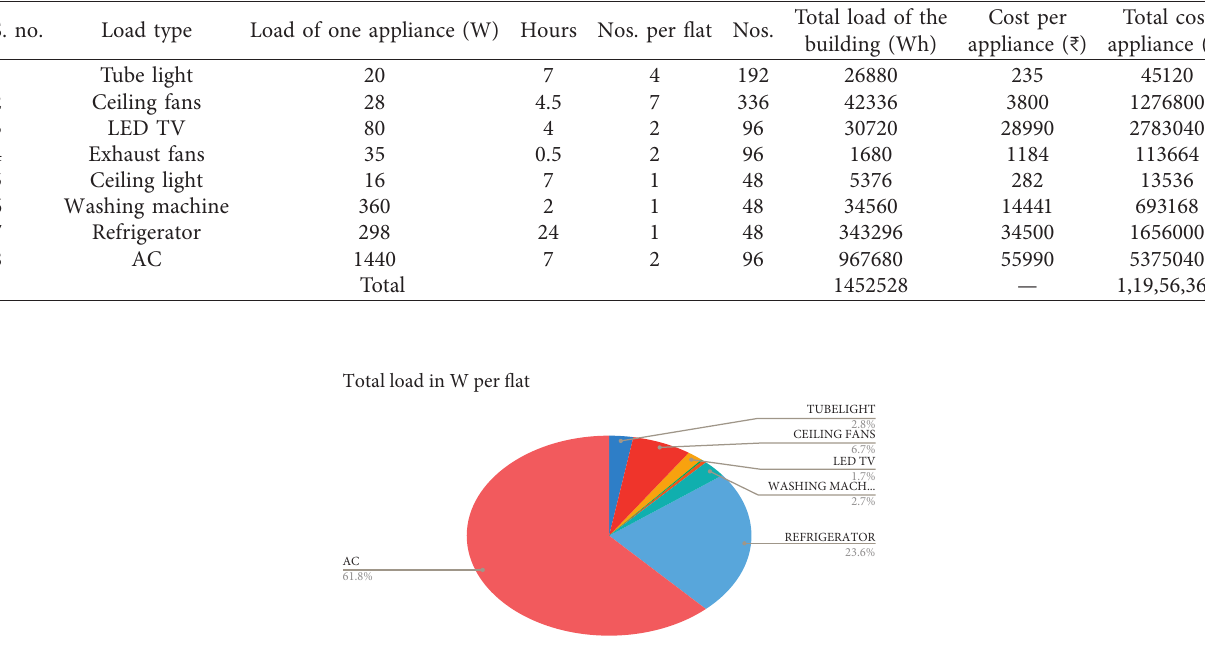
Figure 8: Load distribution—conventional loads—3BHK. Table 7: Load calculation—conventional—common area.